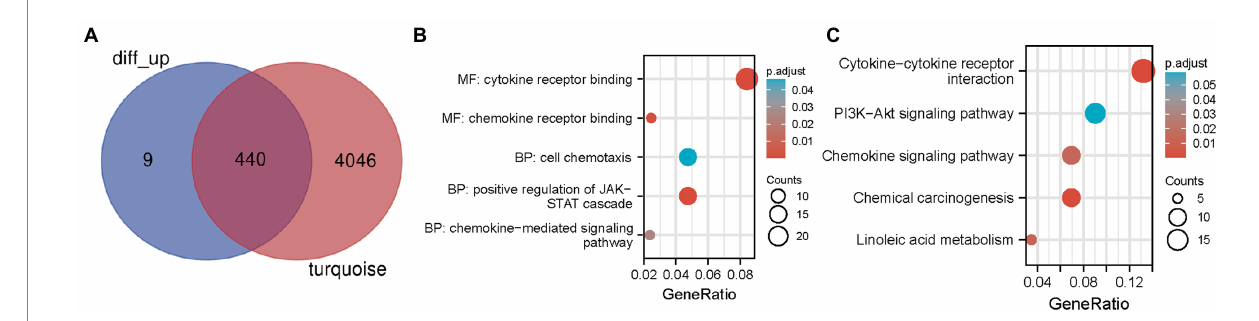
FIGURE 3 Candidate hub genes were screened and validated. (A) Venn diagram revealed 440 overlapping candidate hub genes. (B) GO enrichment analysis of candidate hub genes. (C) KEGG pathway analysis of candidate hub genes.